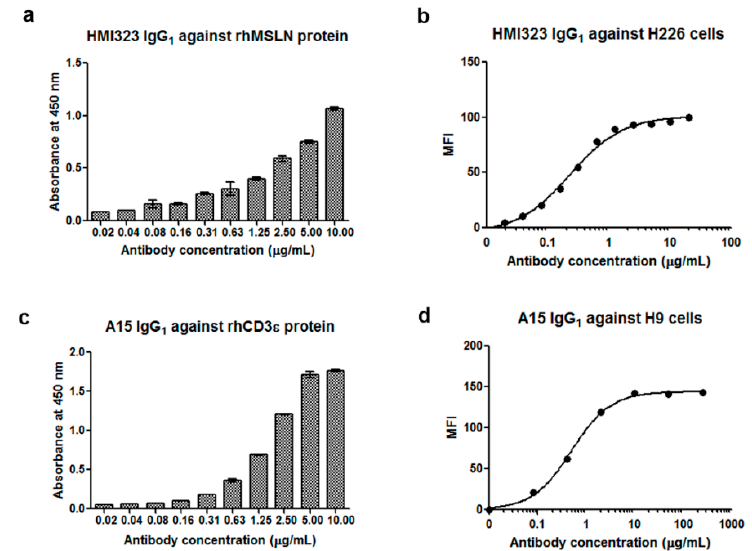
Figure 1. Reactivity of monoclonal antibodies against human mesothelin (MSLN) or human CD3 ε . ( a ) Reactivity of HMI323 IgG 1 against human MSLN protein was investigated by enzyme immunoassay. ( b ) The binding activity of HMI323 IgG 1 to the MSLN-expressing lung cancer cell line was evaluated by flow cytometry. ( c ) Reactivity of A15 IgG 1 against CD3 ε protein was measured by enzyme immunoassay. ( d ) Binding of A15 IgG 1 to human T cells was evaluated by flow cytometry.